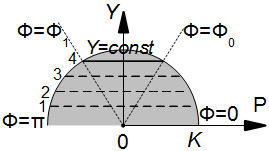
Horizontal chords on the semicircle. The example chords are numbered so that they can be identified after transformations that will be shown below.